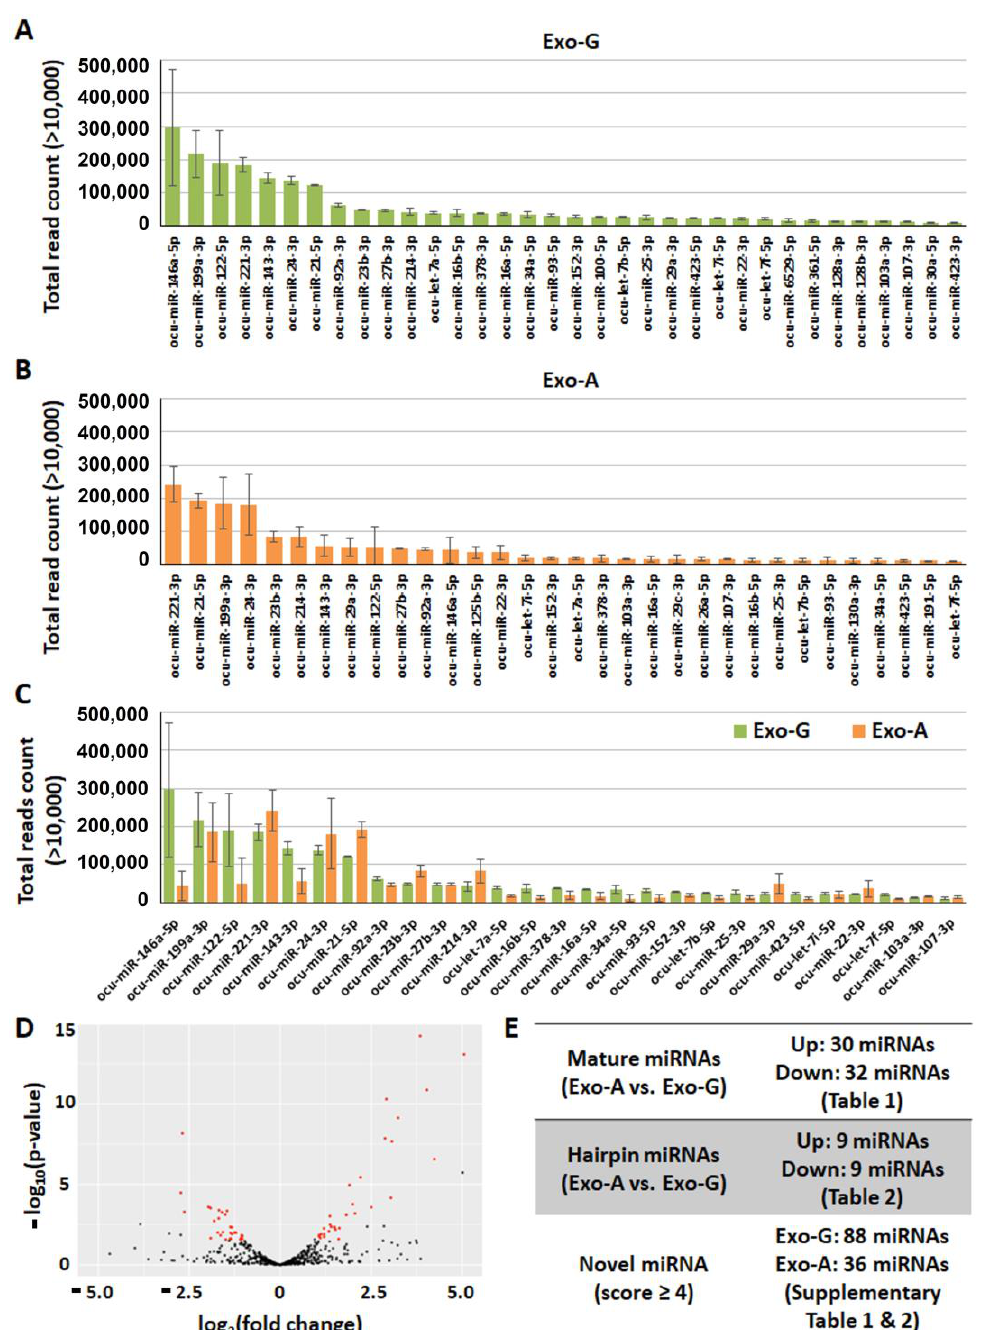
Figure 4. MicroRNA (miRNA) profiling of rabbit (Oryctolagus cuniculus: ocu) dental pulp stem cells-derived exosomes (DPSC-Exos) via next-generation sequencing (NGS). Exosomes were isolated from DPSCs cultured under growth (Exo-G) or angiogenic differentiation conditions (Exo-A). ( A ) Mature miRNAs with over 10,000 total read counts in Exo-G. ( B ) Mature miRNAs with over 10,000 total read counts in Exo-A. ( C ) Mature miRNAs with over 10,000 total read counts in both Exo-G and Exo-A. ( D ) Volcano plot of Exo-A versus Exo-G. Red: significantly up/down-expressed miRNAs. ( E ) The number of identified miRNAs.